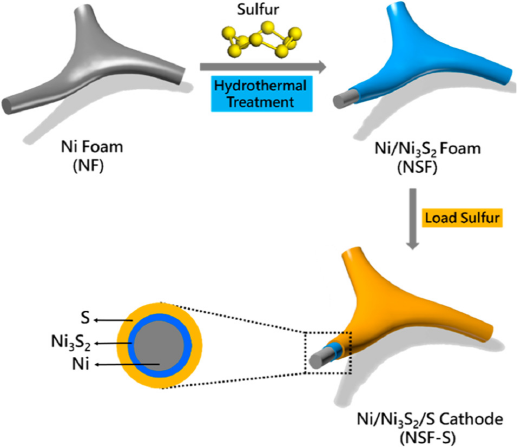
Figure 9. Schematic illustration of the Ni/Ni 3 S 2 /S hybrid cathode. Reproduced with permission from [84]. American Chemical Society, 2017.